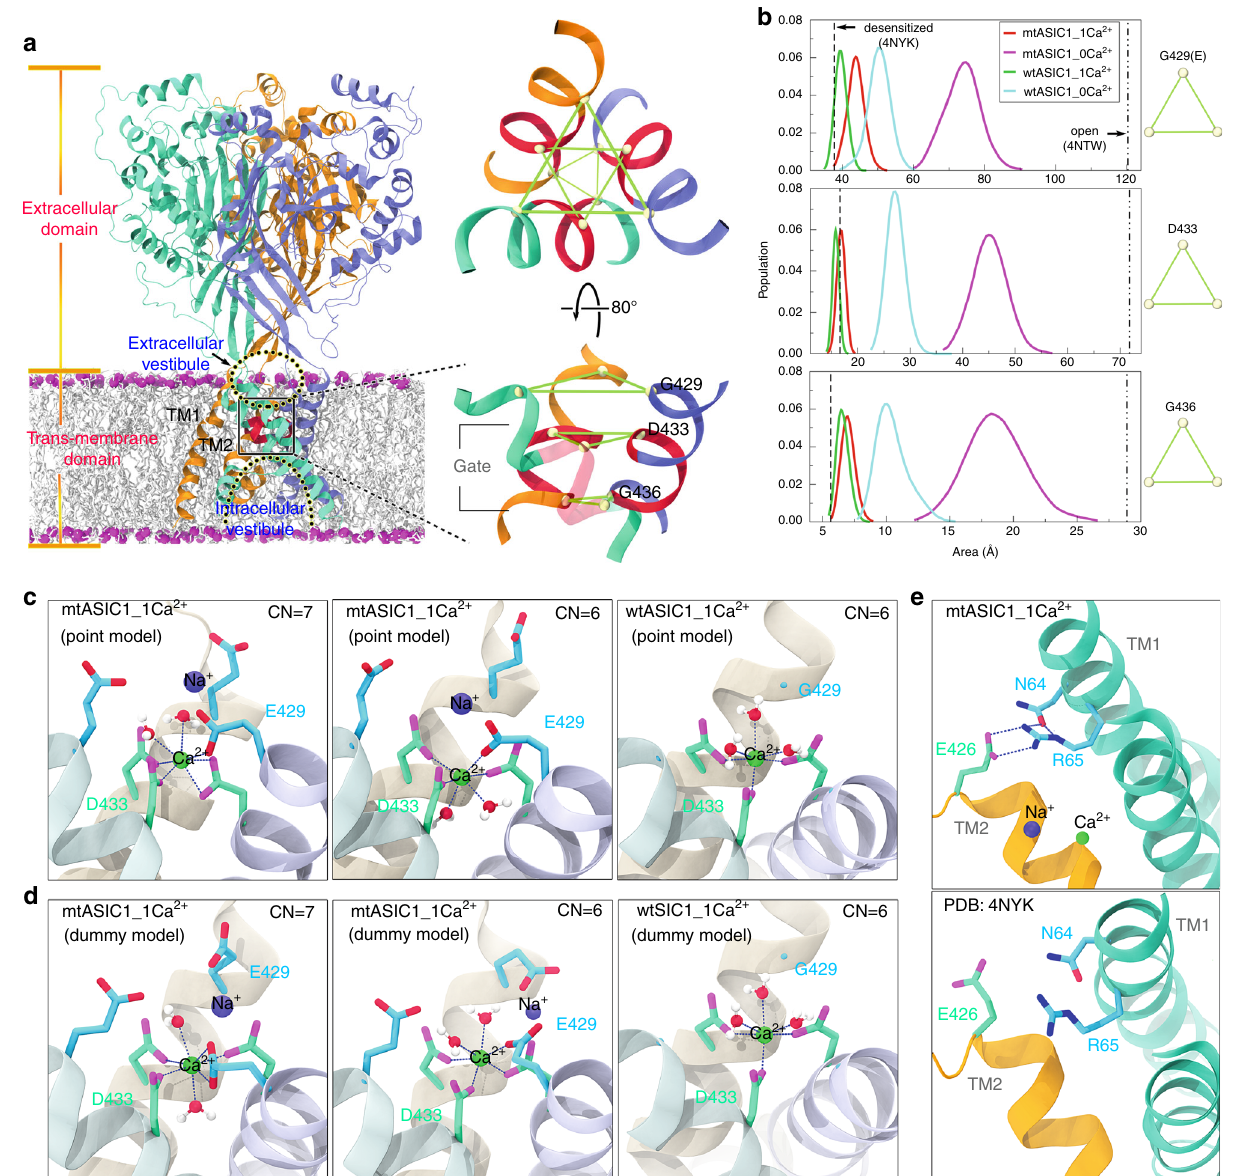
Fig. 3 Molecular dynamics simulations reveal a stable Ca 2 + -binding site in the ASIC channels. a cASIC1 homotrimer embedded in the POPE lipid bilayer and close-up view of the channel pore. The lipid phosphorus atoms are showed as magenta spheres and the three protein subunits are represented as cyan, orange and ice blue ribbons, respectively, with the pore gate highlighted in red. The extracellular and intracellular vestibules are indicated by dotted lines. The C α atoms of the residues at positions 429 (target mutation site), 433, and 436 are displayed as spheres. b Probability distribution of the area of the triangle formed by the C α atoms of symmetry-related Gly429 (or Glu429 in the mutant systems) (upper), Asp433 (middle), and Gly436 (lower). The red and magenta curves correspond to the cASIC1 G429E systems with 1 Ca 2 + (mtASIC1_1Ca 2 + ) and without Ca 2 + (mtASIC1_0Ca 2 + ) bound, respectively, and the green and cyan curves denote the wild-type systems with 1 Ca 2 + (wtASIC1_1Ca 2 + ) and without Ca 2 + (wtASIC1_0Ca 2 + ), respectively. The dashed and dashed-dotted lines denote the area values calculated from the crystal structures in desensitized and wide open states (PDB codes: 4NYK & 4NTW), respectively. c , d The Ca 2 + block site identi fi ed at the pore entrance with the Ca 2 + point charge ( c ) and dummy atom models ( d ). The Ca 2 + in the mutant channel (mtASIC1_1Ca 2 + ) forms both pentagonal bi-pyramidal and octahedral coordination ( fi rst and second panels), whereas the Ca 2 + binding in the wild channel (wtASIC1_1Ca 2 + ) assumes an exclusive octahedral geometry (third panel). The residues Glu429 and Asp33 and water molecules coordinating Ca 2 + are represented in stick and ball-and-stick models, respectively, and the C α atom of Gly429 in the wild-type system is shown as a sphere. The coordination number (CN) is indicated at the upper-right corner of each panel. For clarity, the dummy complex in d has been shown as a Lennard – Jones sphere as in c . Statistical analysis of the coordination bonds and angles is reported in Supplementary Table 2. e Inter-subunit ionic interactions of Glu426 in TM2 and Arg65 in TM1 stabilizing a putative intermediate state of the G429E